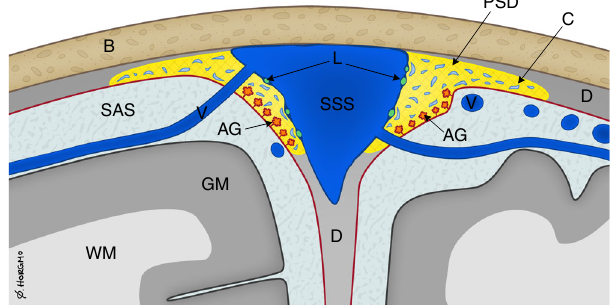
Fig. 6 Cartoon illustrating reported microstructural elements within the parasagittal dura based on refs. 14,15 . a The parasagittal dura (PSD, colored yellow) contain a network of intradural channels (C, colored light blue), coalescing into lateral lacunae medially (not shown), being in close relation with a dense carpet of intradural arachnoid granulations (AG, orange color). PSD is most prominent at level where the cortical veins (V, dark blue) enter the superior sagittal sinus (SSS, dark blue). Lymphatic vessels (L, green) reside at the SSS wall. The microstructural elements within PSD are of sub-millimeter thickness and therefore not expected to be visualized on MRI with 1 mm resolution. D dura, GM gray matter, SAS subarachnoid space, WM white matter. Illustrations: Øystein Horgmo, University of